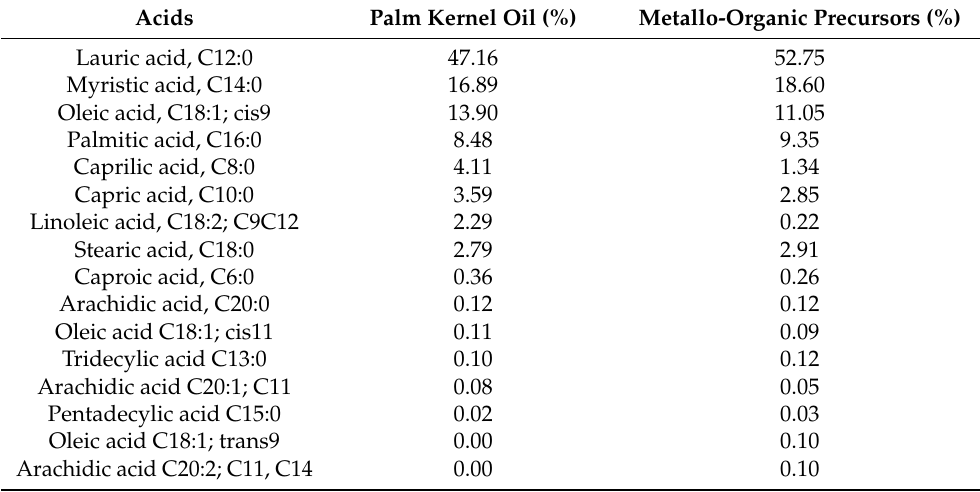
Table 3. Carboxylate contents in the metallo-organic precursors and the palm kernel oil.